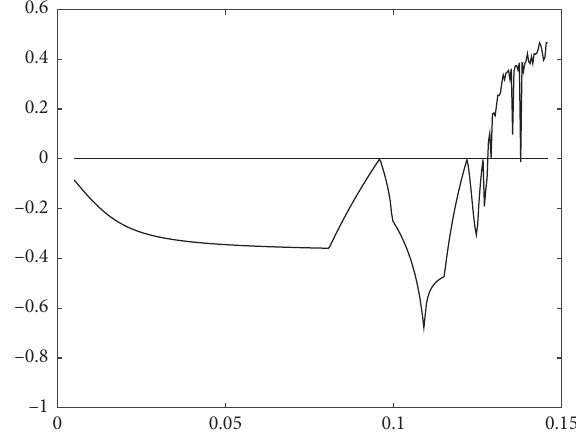
Figure 12: The largest Lyapunov exponent when β